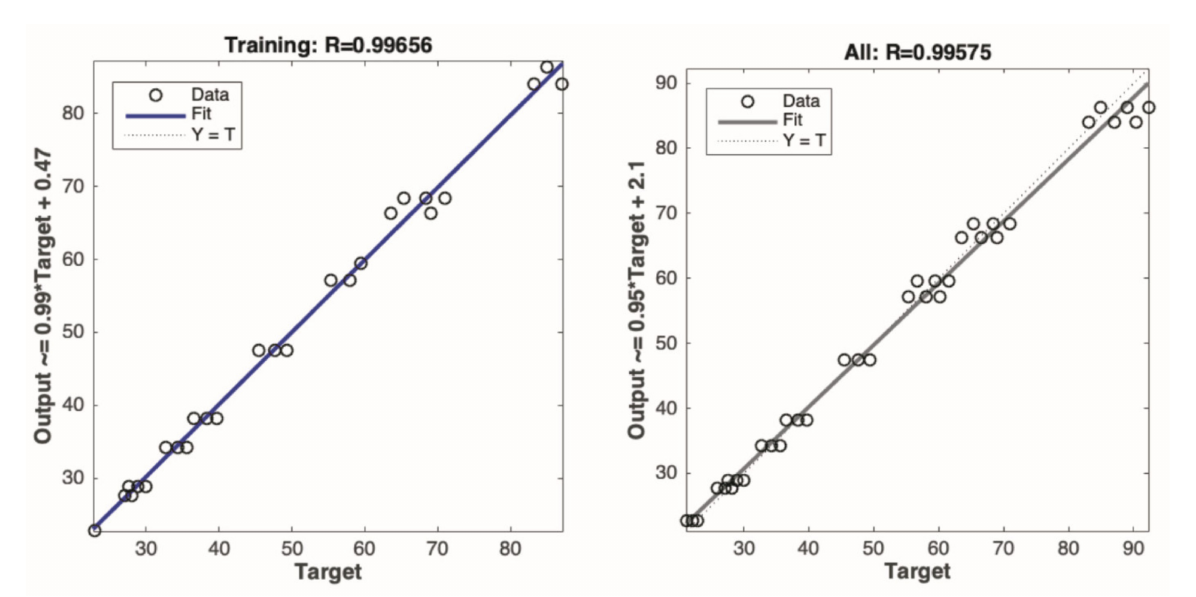
Figure 13. Regression performance of the ANN